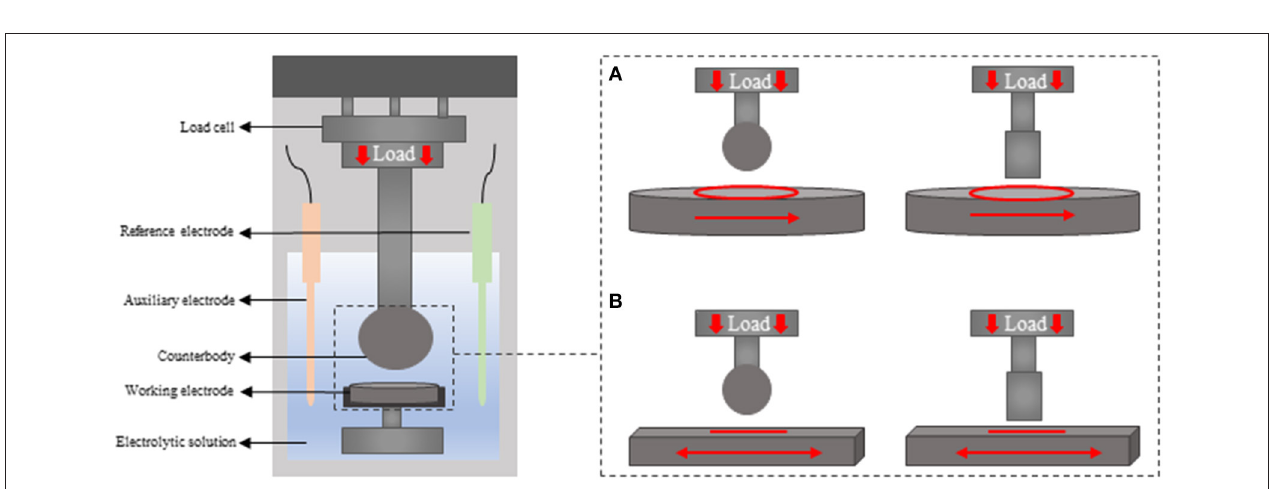
monitor the current generated during the corrosion tests with mechanical events (Rocha et al.,